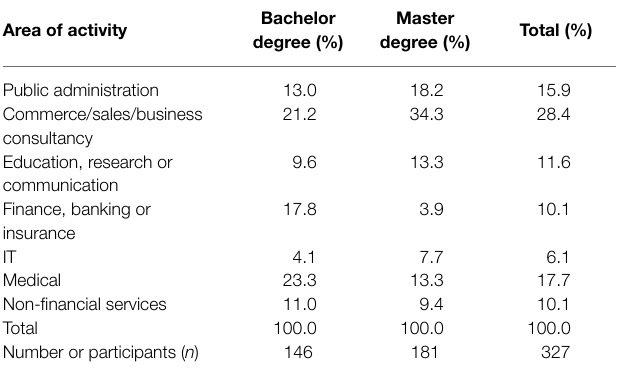
TABLE 4 | Distribution of respondents by area of activity and level of